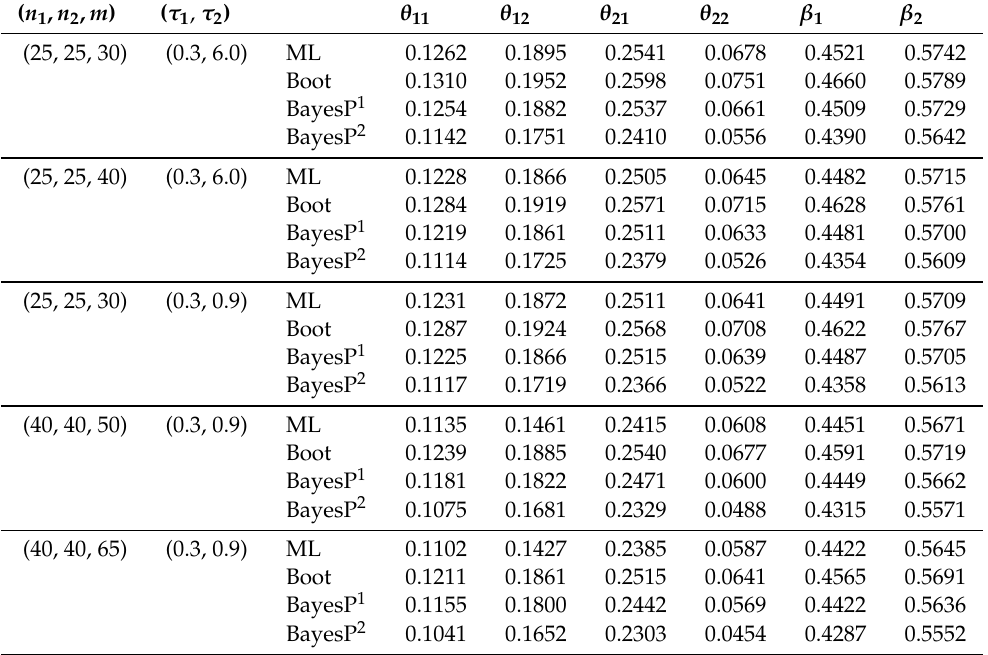
Table 3. MSEs of the parameter estimates for the Θ 2 = { 0.2, 0.3,0.4,0.2,1.0,1.0 } .